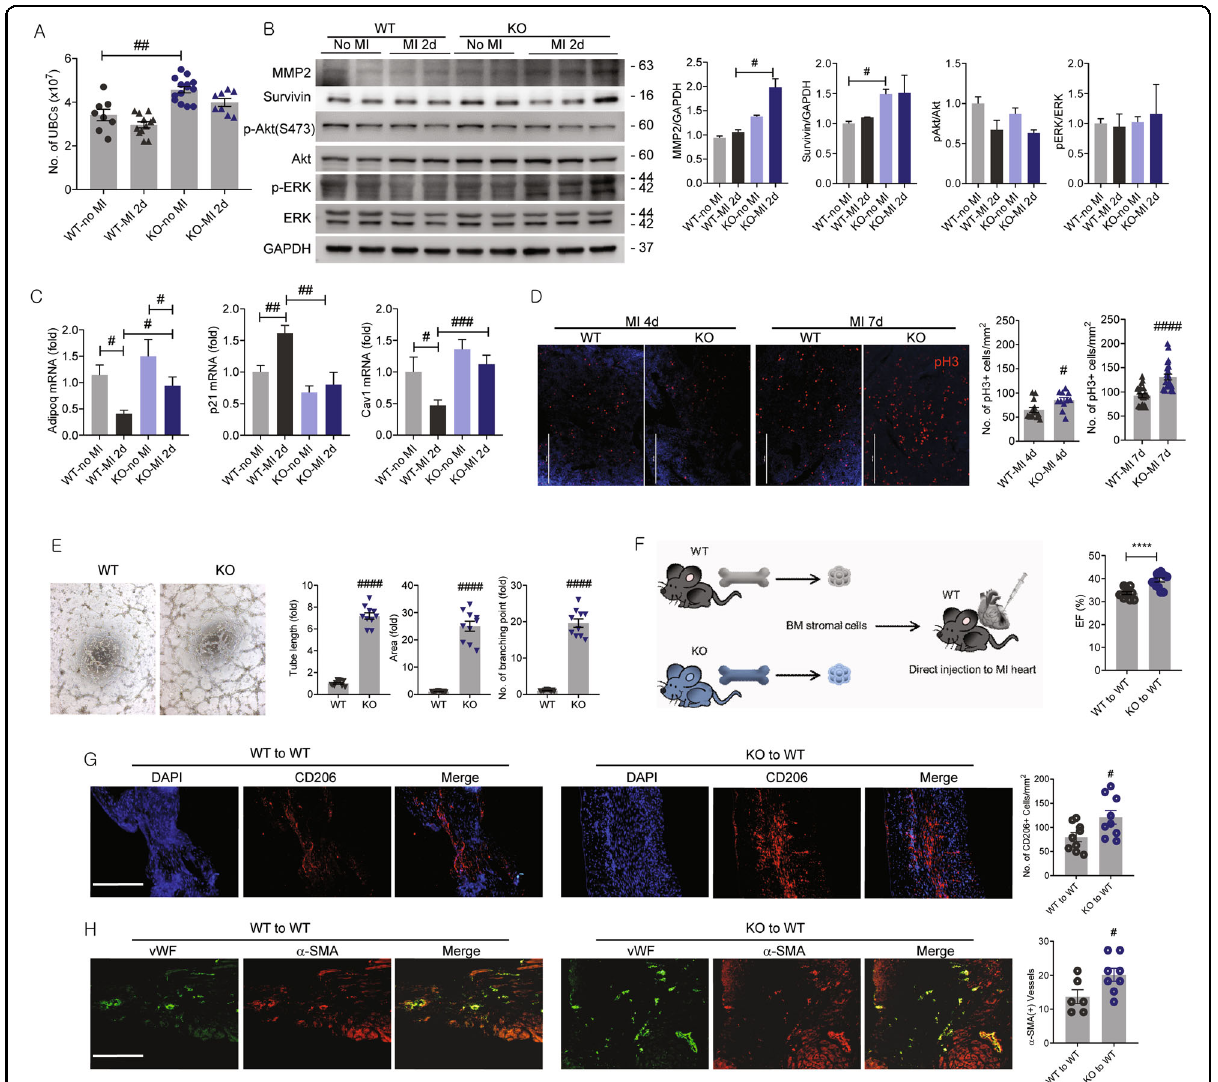
Fig. 2 Characterization of Retnla knockout in unsorted bone marrow cells exhibiting cardiac protective effect. A The number of unsorted bone marrow cells (UBCs) was higher in Retnla knockout (KO) mice regardless of myocardial infarction (MI). B Cell survival and proliferation-related mediators were analyzed in UBCs isolated from WT and Retnla KO mice by western blot. C UBCs were isolated from WT and KO mice 2 days after MI, and mRNA levels of adiponectin (Adipoq), p21, and caveolin-1 (Cav1) were quanti fi ed by real-time PCR. D The number of phosphorylated histone H3 (pH3)-positive cells in bone marrow was quanti fi ed, and the representative images showed pH3-positive cells (red fl uorescence) in the bone marrow. (WT MI 4d; n = 14, KO MI 4d; n = 11, WT MI 7d; n = 23, KO MI 7d; n = 23). Scale bar, 200 μ m. E To compare the endogenous angiogenic potential of WT and KO mice, mesenchymal stem cells (MSCs) were used. MSCs were isolated from bone marrow and tube formation assay was performed. Tube length, tubular area, and the number of branching points were analyzed in MSCs from wild type and Retnla KO mice. Scale bar, 500 μ m. F UBCs were isolated from WT ( n = 12) or KO mice ( n = 13), and injected into infarcted heart of wild-type mice ( n = 12 in the WT to WT mice, n = 13 in the KO to WT mice). After 2 weeks, cardiac function was analyzed, and the representative echocardiograms were shown. G , H Immuno fl uorescence staining showed larger distributions of anti-in fl ammatory CD206( + ) macrophages and vascular density in the KO mice than in the WT mice. EF ejection fraction, FS fractional shortening. Scale bars, 200 μ m. Data are represented as mean ± SEM. # P < 0.05, ## P < 0.01, ### P < 0.001 (by Student ’ s t test or two-way ANOVA). The image of the mouse (http://clipart-library.com/clipart/724544.htm) is obtained from clipart library and used under the Creative Commons Attribution-Share Alike 4.0 International license